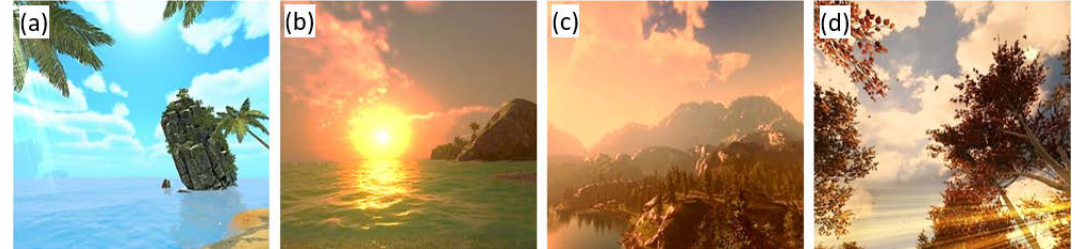
Figure A1. Environment screenshots ( a ) Tropical beach; ( b ) Sunset Beach; ( c ) Mountain sunrise; ( d ) Forest nap.